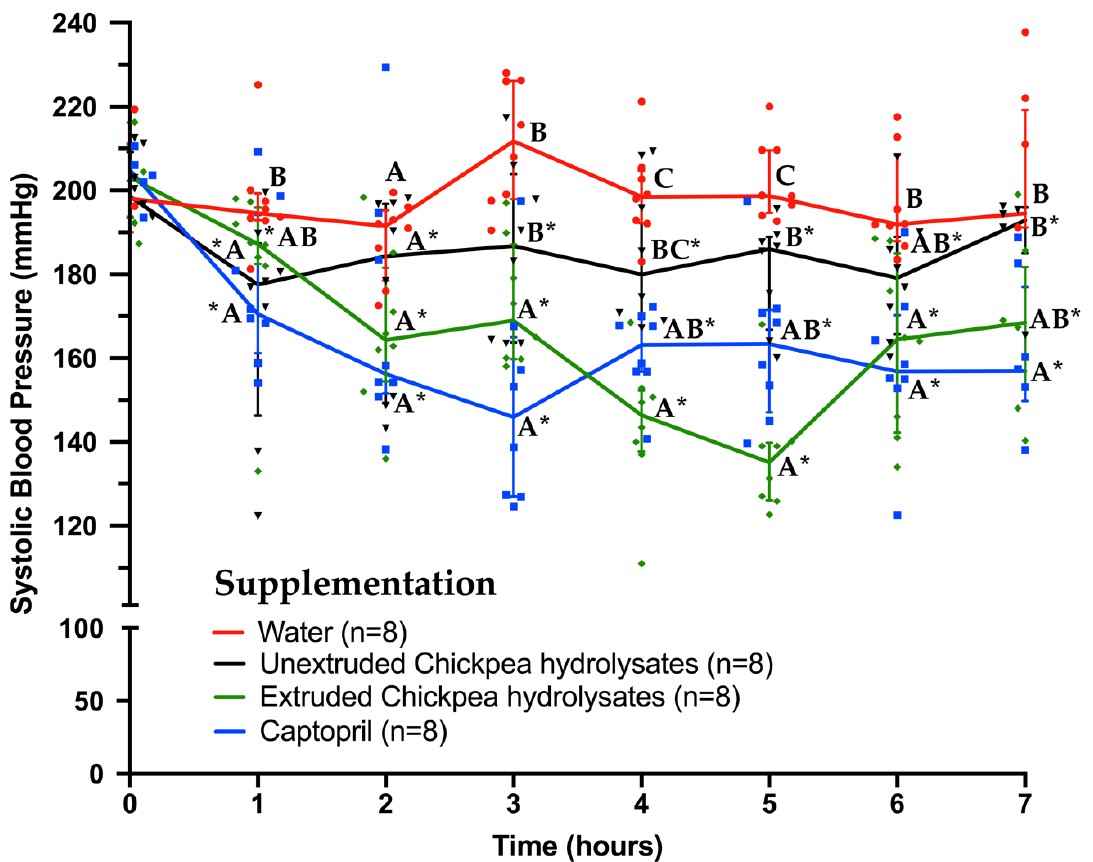
Figure 3. Systolic blood pressure in spontaneously hypertensive rats before (time zero) and after (times 1 to 7 h) supplementation with water (1.0 mL), captopril (25 mg/kg), extruded, and unextruded chickpea hydrolysates (1.2 g/kg each). Horizontally, asterisks in each time point indicate statistically significant differences from their respective basal values (time zero) ( p < 0.05). Vertically, different letters at each time point mean statistically significant differences between groups ( p < 0.05). Red dots (water group), black triangles (unextruded Chickpea hydrolysate group), green rhombus (extruded Chickpea hydrolysate group), and blue squares (captopril group) represent individual systolic blood pressure values from each rat. Data are presented as medians and interquartile ranges.